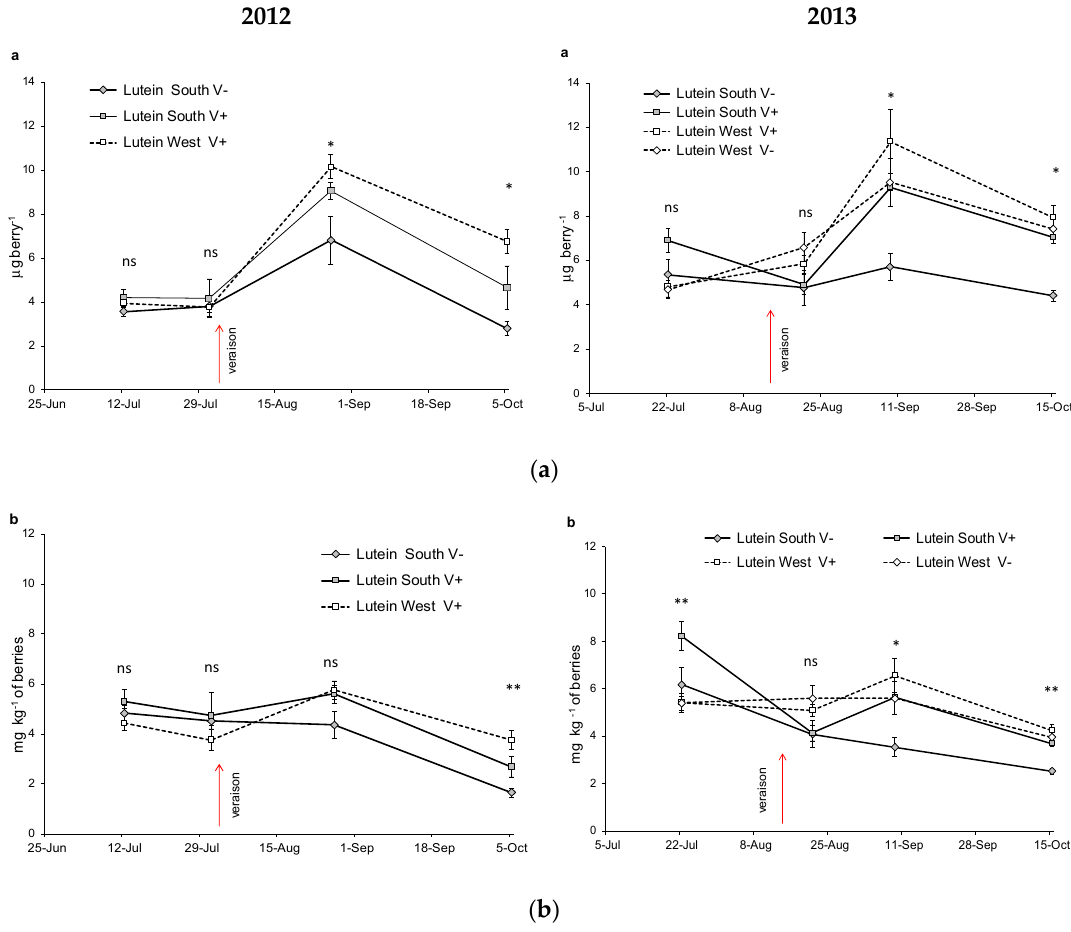
Figure 2. Seasonal changes of lutein as µ g berry − 1 ( a ) and mg kg − 1 of berries, ( b ) in Nebbiolo grapes in 2012 (on the left) and 2013 (on the right), as a function of vine vigor and vineyard aspect. Averages ± standard error ( n = 3). * p < 0.05, ** p < 0.01 indicate the significance of differences among treatments.